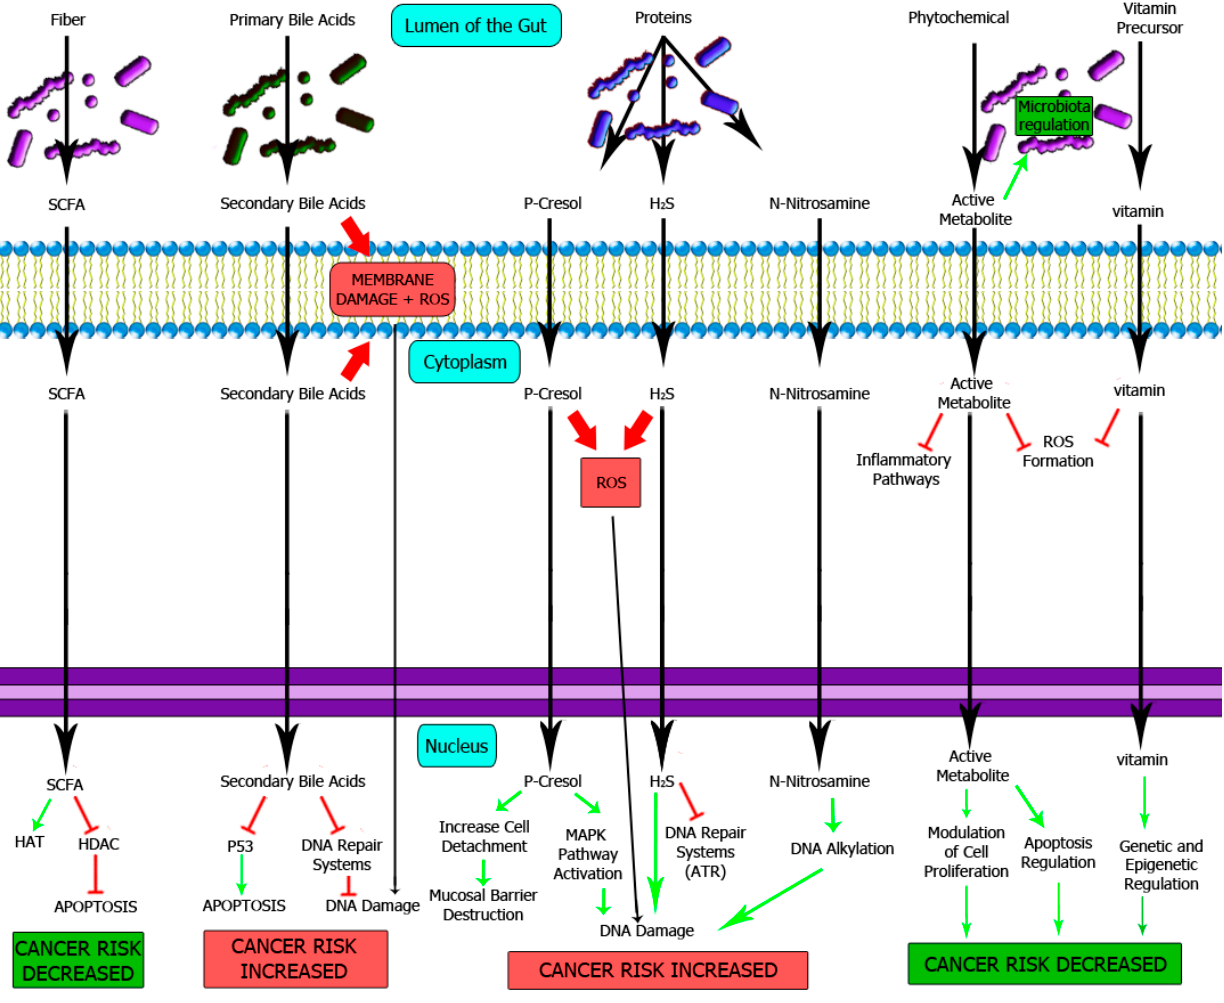
Figure 2. Influence of microbiota-processed nutrients on colon epithelium homeostasis. The importance of normal microbiota has been extensively studied, with a major impact on the protection against CRC. For instance, short-chain fatty acids are tumour suppressor metabolites produced by healthy typical microbiota that protects normal epithelium against neoplasia through an epigenetic mechanism. On the other hand, an excess of oncometabolites such as p-cresol, secondary bile acids or N-nitrosamines will favor mutagenesis and cancer development. SCFA: Short-chain fatty acids, HAT: Histone acetyltransferase, HDAC: Histone deacetylase.